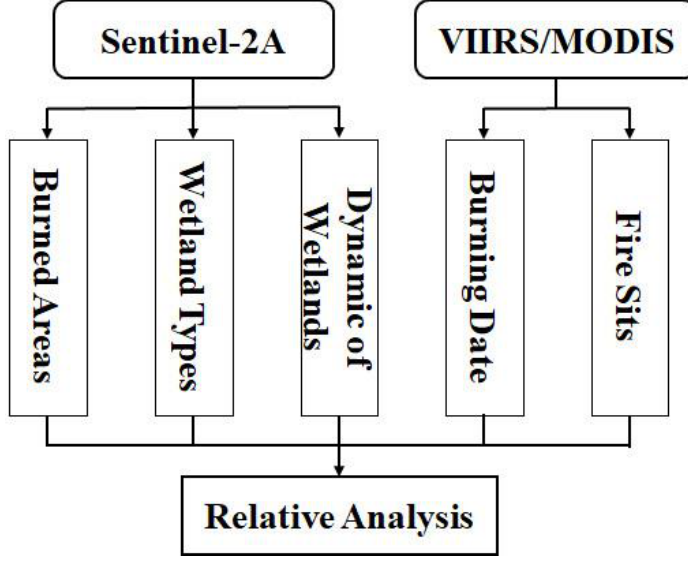
Figure 2. The flow chart of wetland fires in this study.